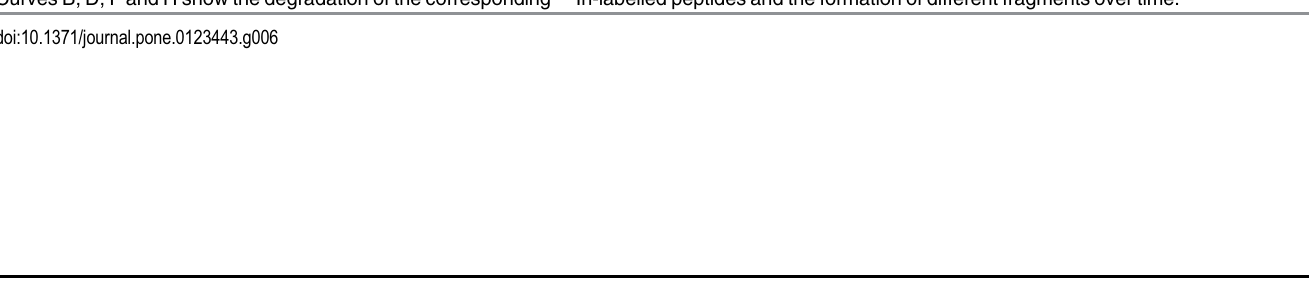
PLOS ONE | DOI:10.1371/journal.pone.0123443 April 9,